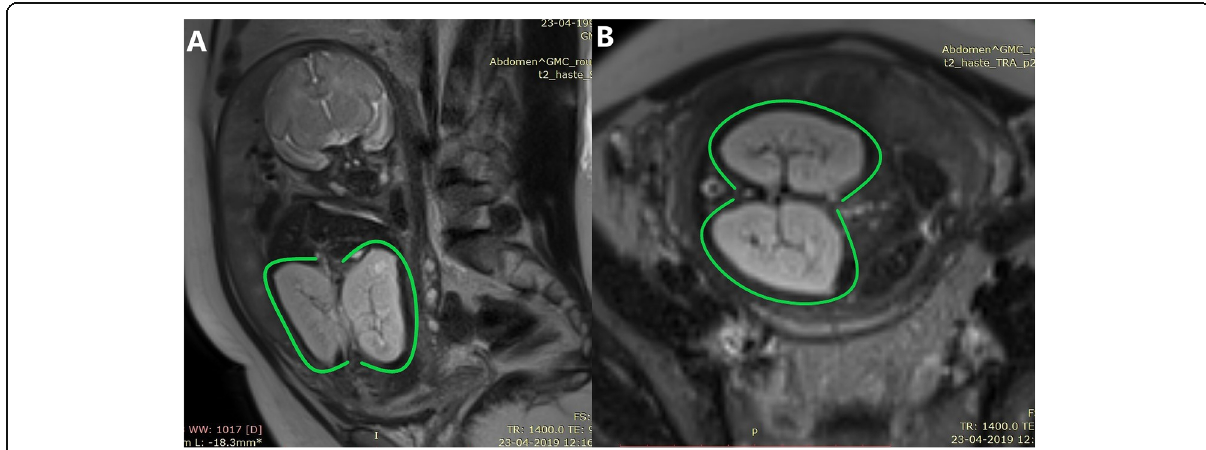
Fig. 3 Bilateral autosomal recessive polycystic kidney disease: maternal age: 27 years; period of gestation: 32 weeks 6 days; T2 HASTE coronal ( a ) and axial ( b ): nephromegaly with diffusely increased signal on fluid-sensitive sequences involving both the right and left kidneys (green arcs); the urinary bladder was not visualized (not shown); there was also evidence of anhydramnios and bilateral pulmonary